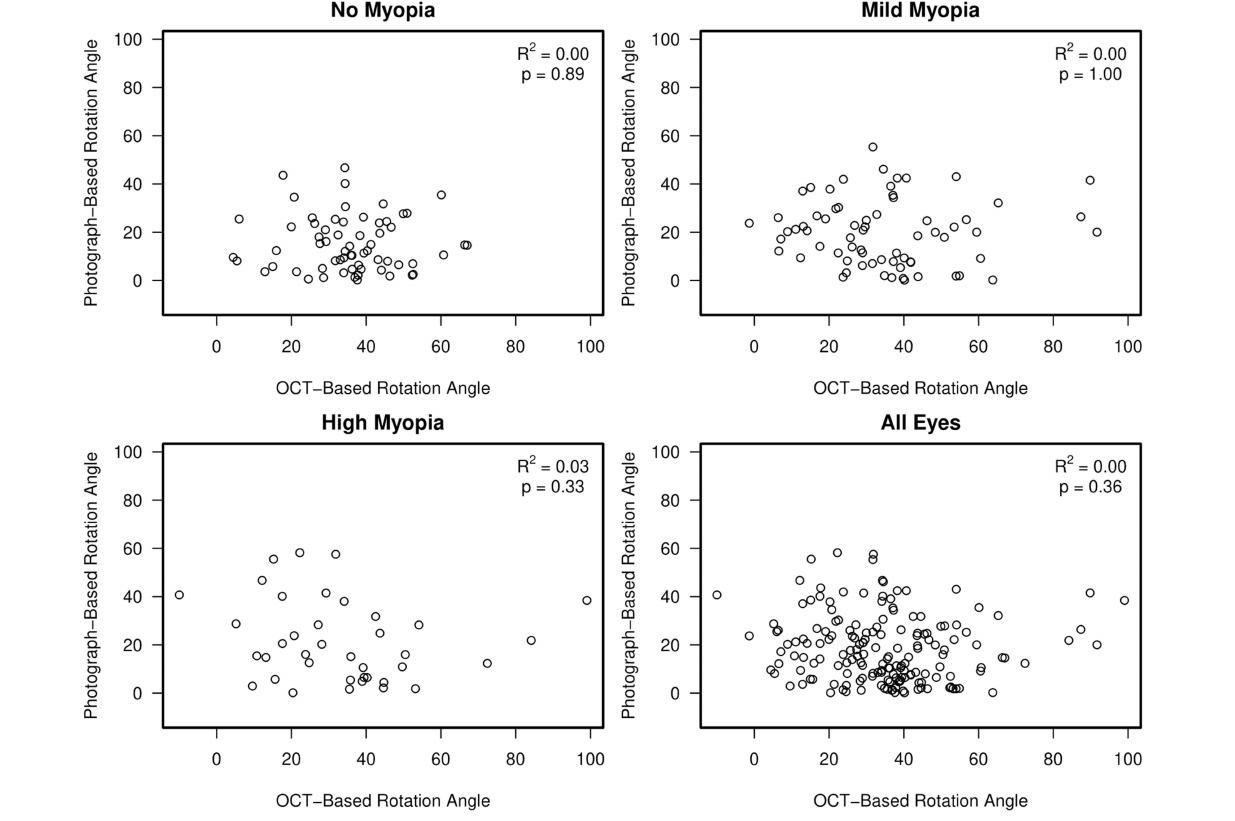
FIGURE 5 | Scatterplots showing no association between semi-automated, clinical disc margin photograph-based rotation angle and automated, BMO OCT-based rotation